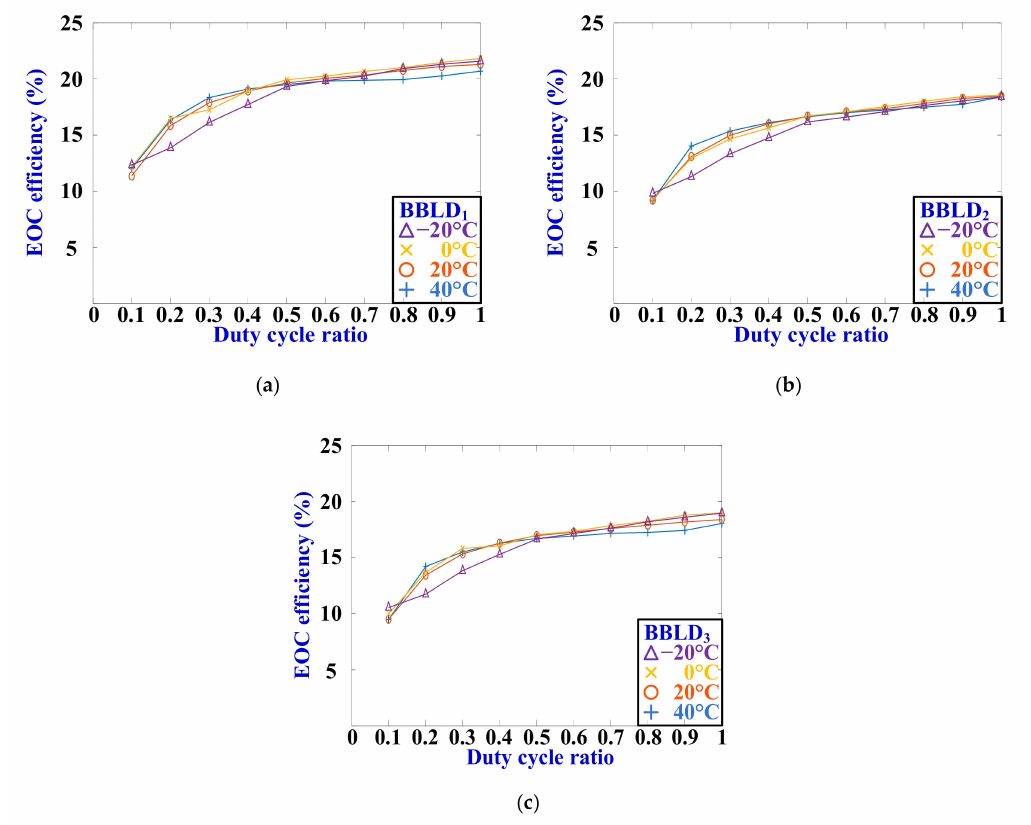
Figure 15. EOC e ffi ciency using electrical power RMS value calculation ( f s = 400 Hz). ( a ) BBLD 1 . ( b ) BBLD 2 . ( c ) BBLD 3 .